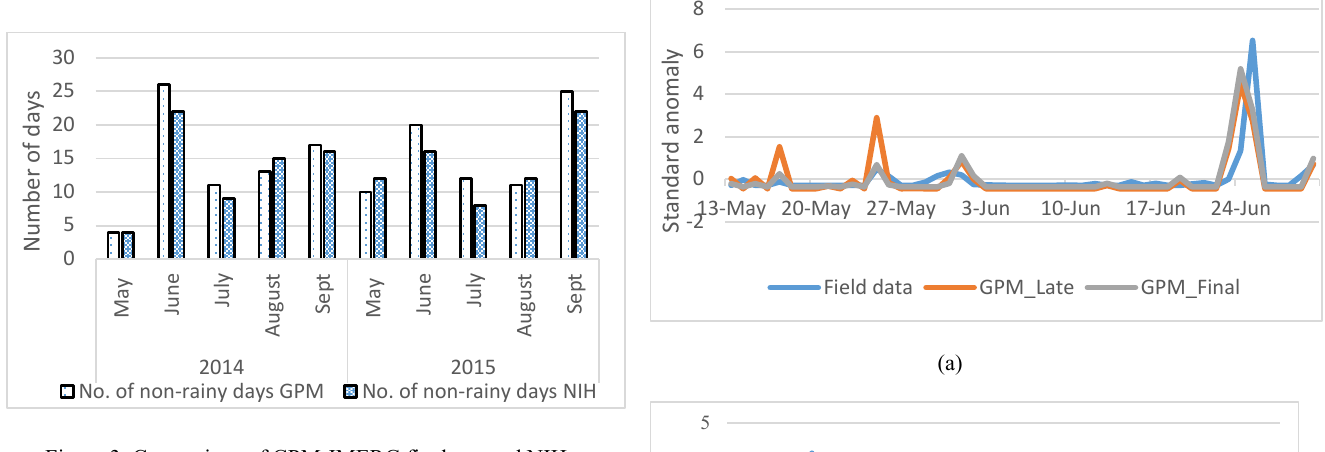
Figure 3. Comparison of GPM-IMERG final run and NIH precipitation data for the identification of non-rainy